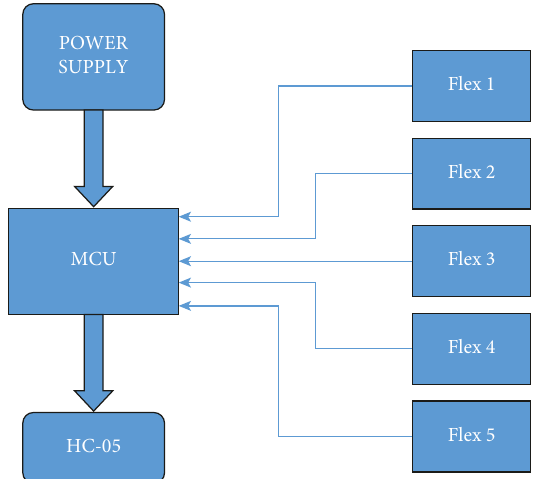
Figure 1: Block diagram of microcontroller in the master module.